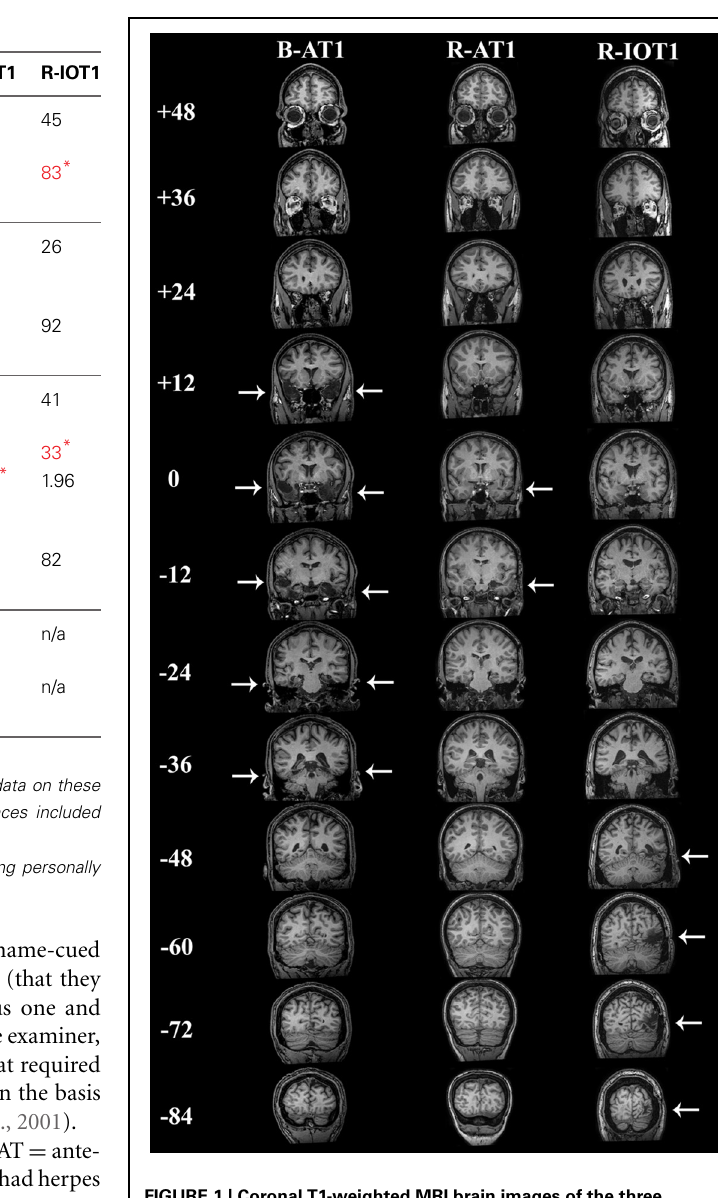
FIGURE 1 | Coronal T1-weighted MRI brain images of the three patients, standardized to Talairach space. Slices were taken every 12mm, from y = + 48mm to y = − 84mm. B-AT1 has large bilateral lesions of the anterior temporal lobes following herpes encephalitis ( + 12 to − 36mm). R-AT1 has a small surgical lesion in the right anterior temporal lobe, additionally affecting the right hippocampus and amygdala (0–12mm). R-IOT1 has a single right inferior occipitotemporal lesion from his prior hemorrhage ( − 48 to −